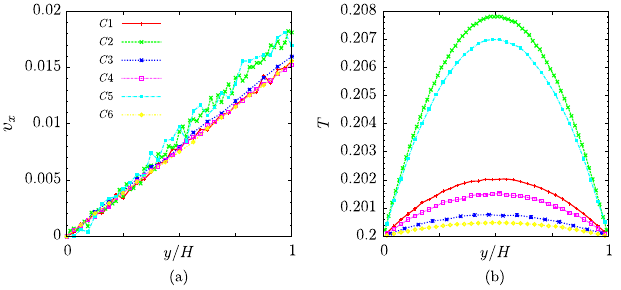
FIG. 7. The comparisons of the (a) velocity and (b) temperature profiles under the various calculation conditions for the applied shear stress σ 0 ¼ 0 . 01 .